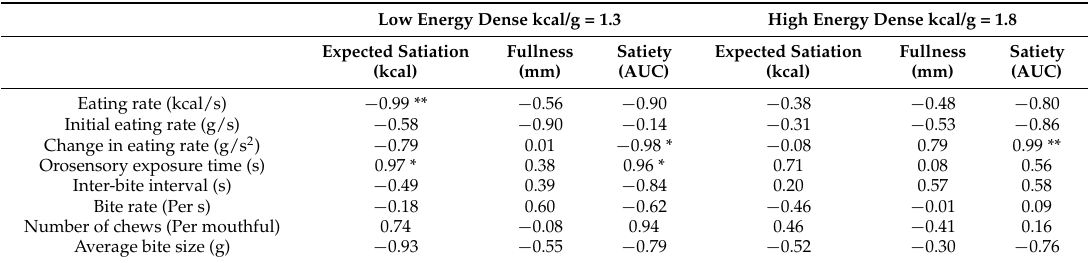
Table 4. In each subgroup, relationships (Pearson’s partial correlations) between oral processing characteristics and expected satiation (kcal), post-meal fullness (mm) and satiety (AUC) a . Low Energy Dense kcal/g =